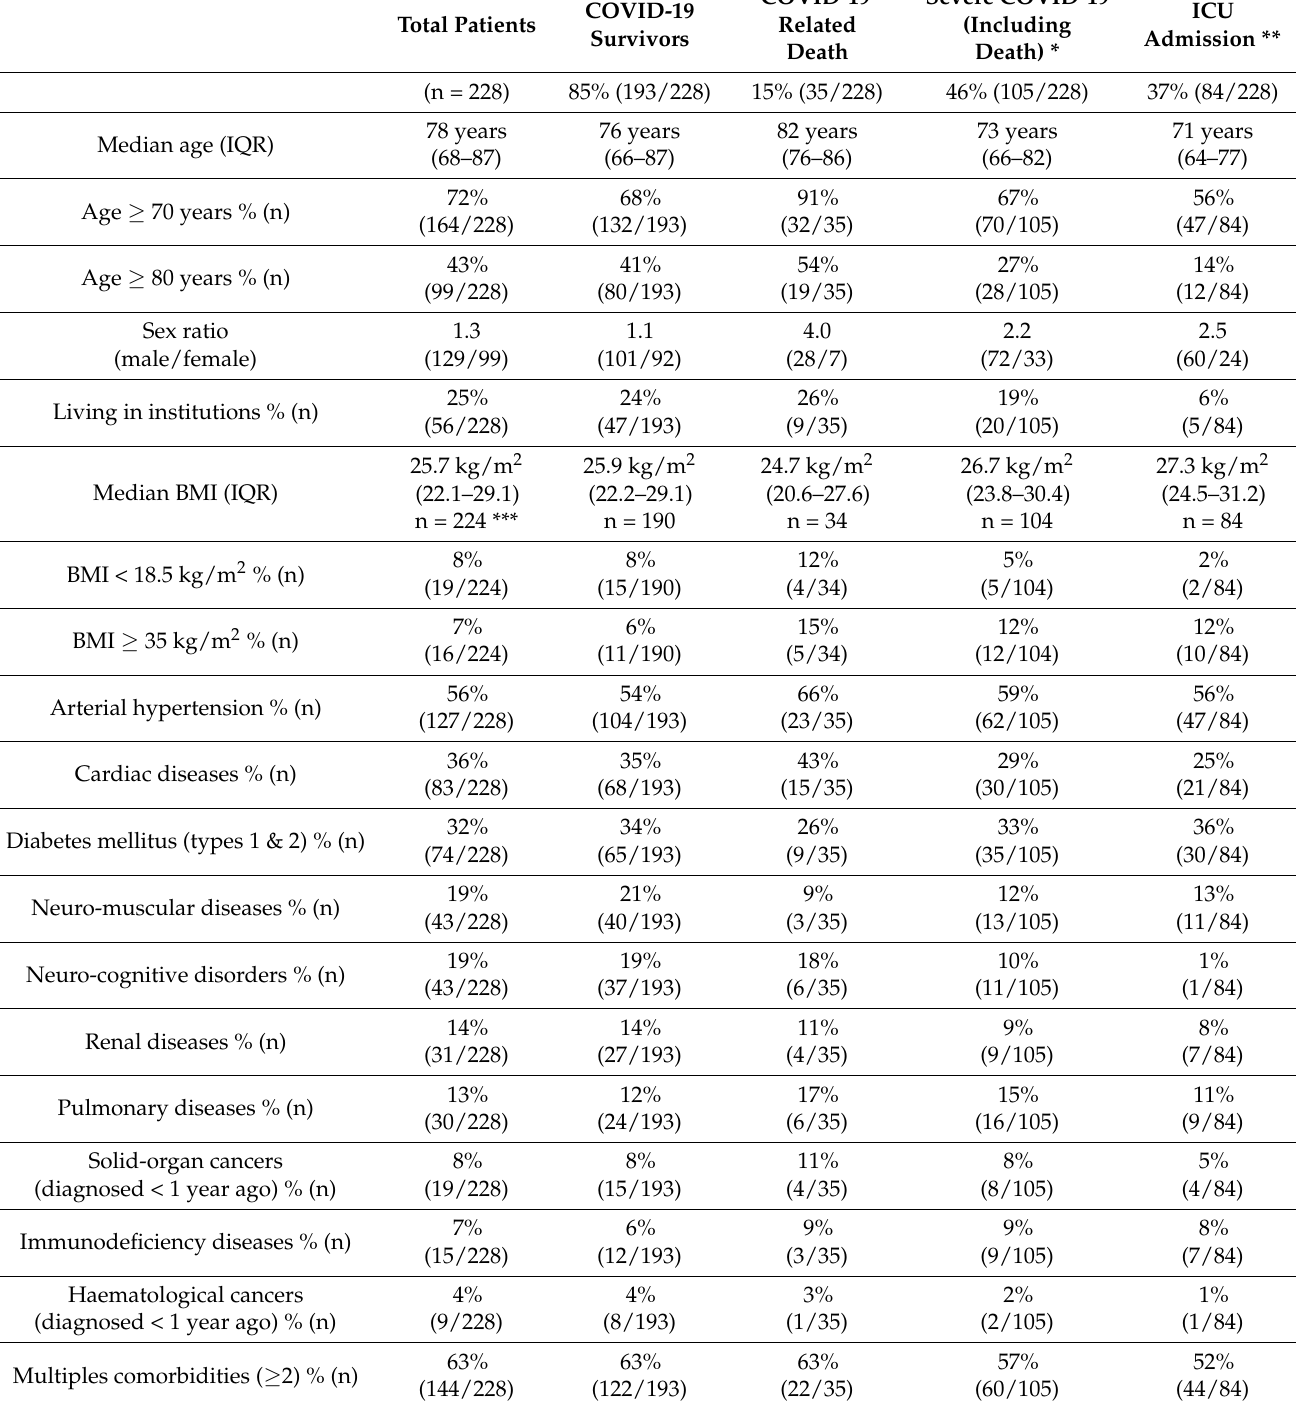
Table 1. Baseline demographics, comorbidities and clinical